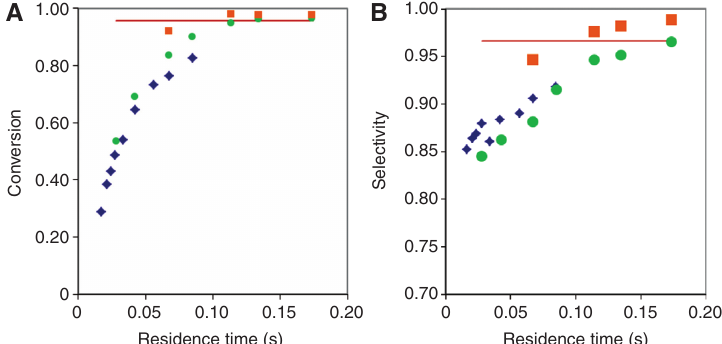
Figure 4 Influence of the dead volume on (A) the methanol conversion and (B) methyl chloride selectivity. ( ) one microreactor ( ) two microreactors ( ) two microreactors no quartz wool. T = 340 ° C. The red line represents the thermodynamic equilibrium.